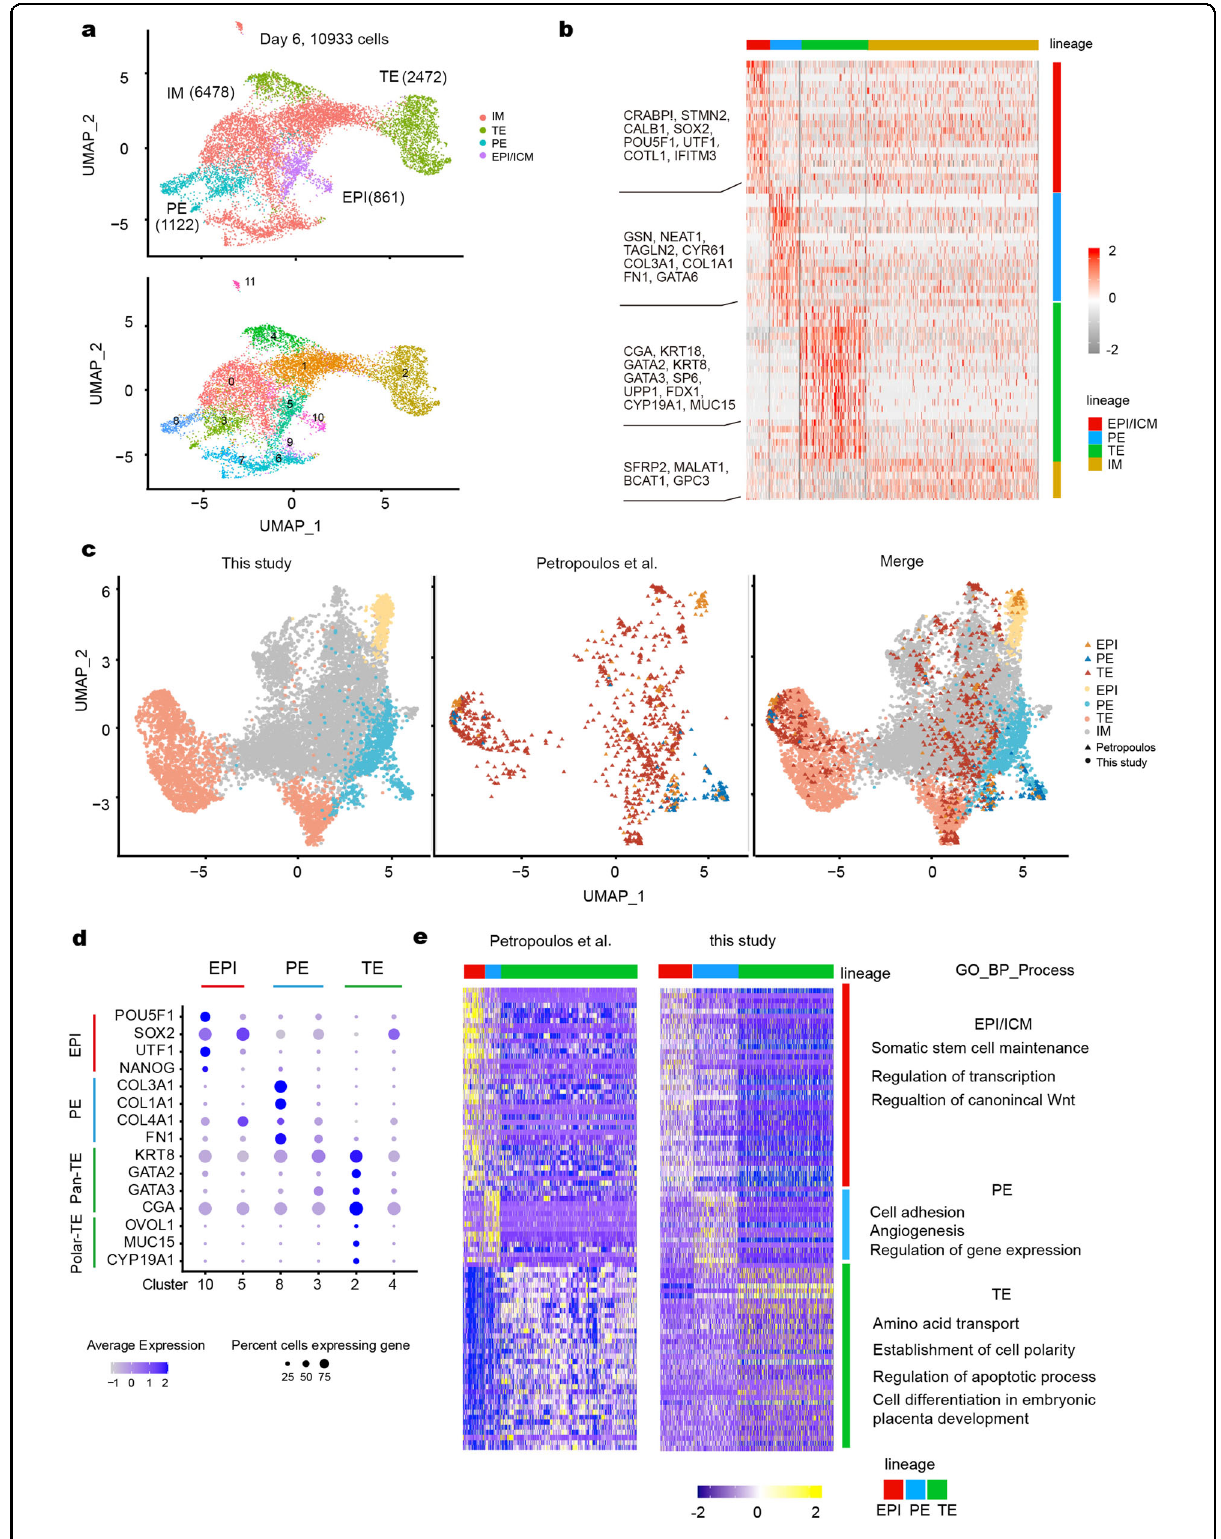
Fig. 3 (See legend on next